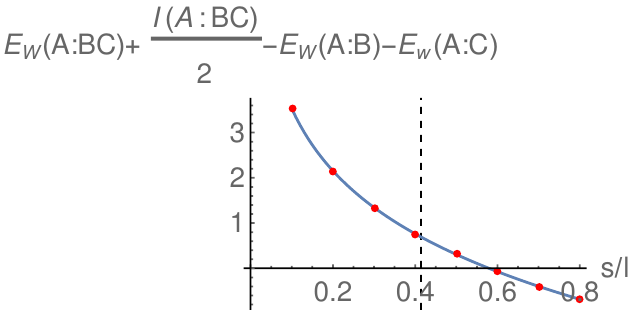
Figure 8 . E W ( A : BC ) + I ( A : BC ) / 2 − E W ( A : B ) − E W ( A : C ) for different s/l ratios. Analytic result is depicted by a solid curve. Numerical result is shown by red dots. Bipartite critical point at s/l ≈ 0 . 414 is indicated by a dashed line.